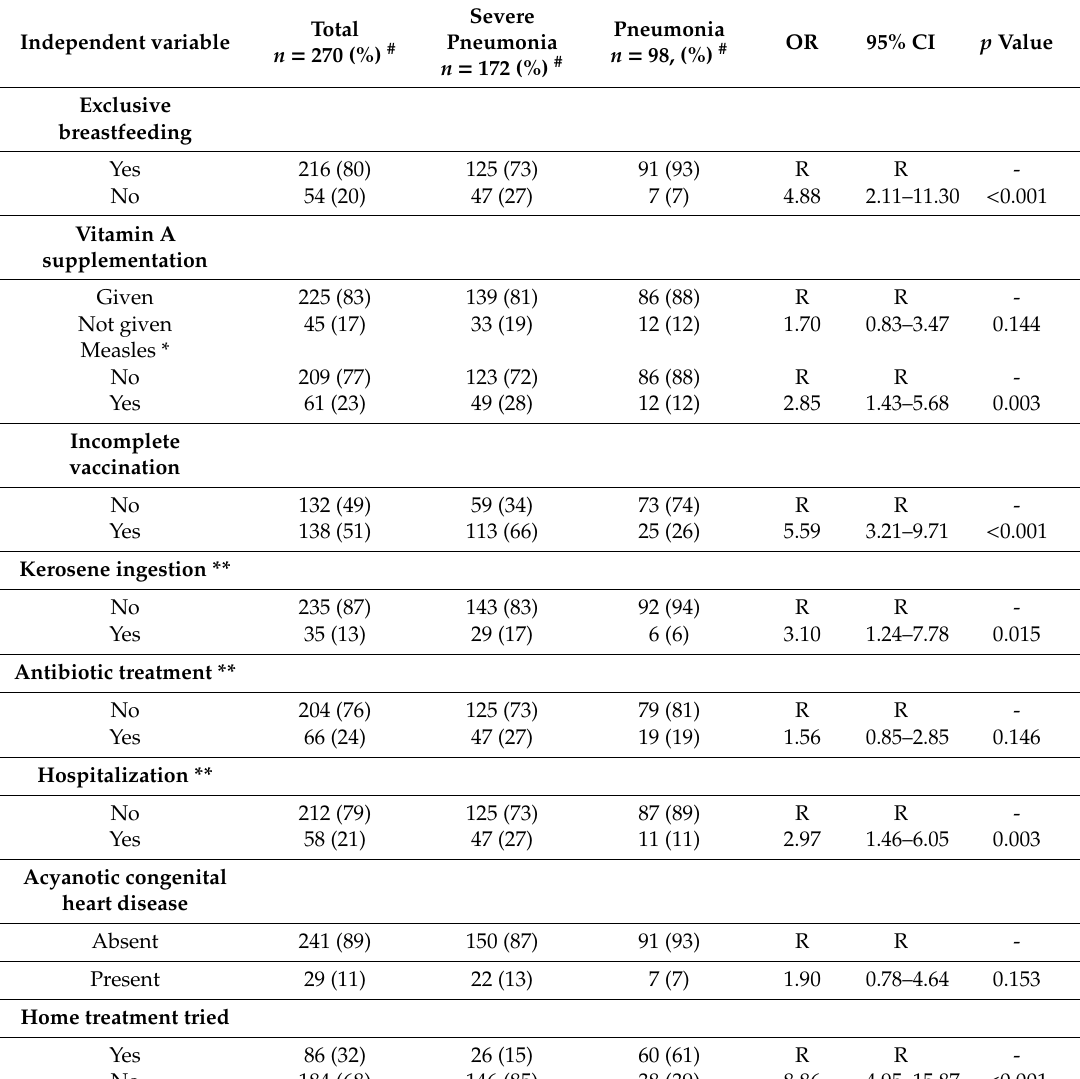
Table 3. Bivariate associations between past history-related covariates and severe pneumonia in hospitalized children ( n = 270) in Ujjain,